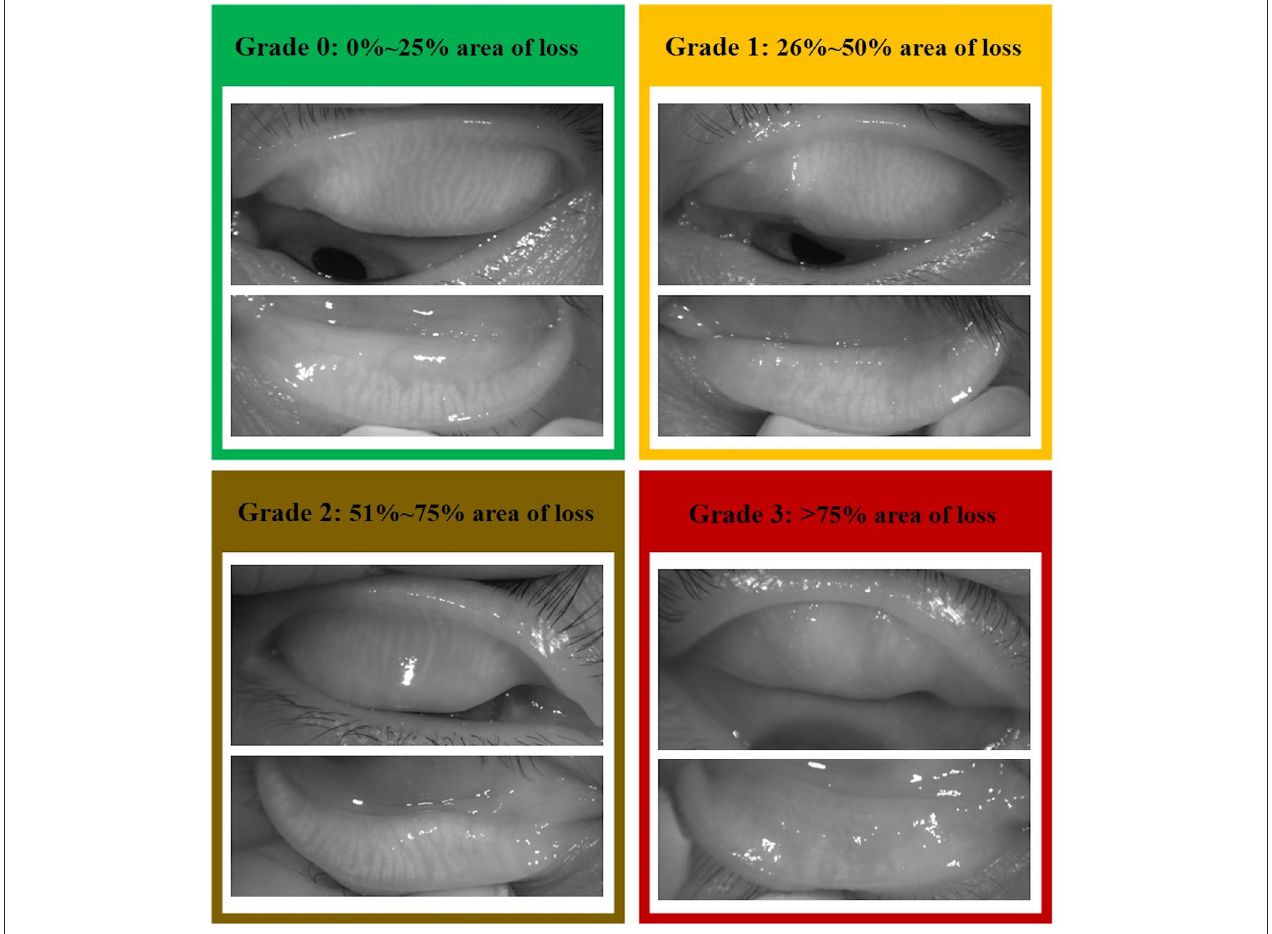
FIGURE 1 | The meibograde grading system reported by Adil et al. was referred to do subjective grading of meibomian gland (MG)